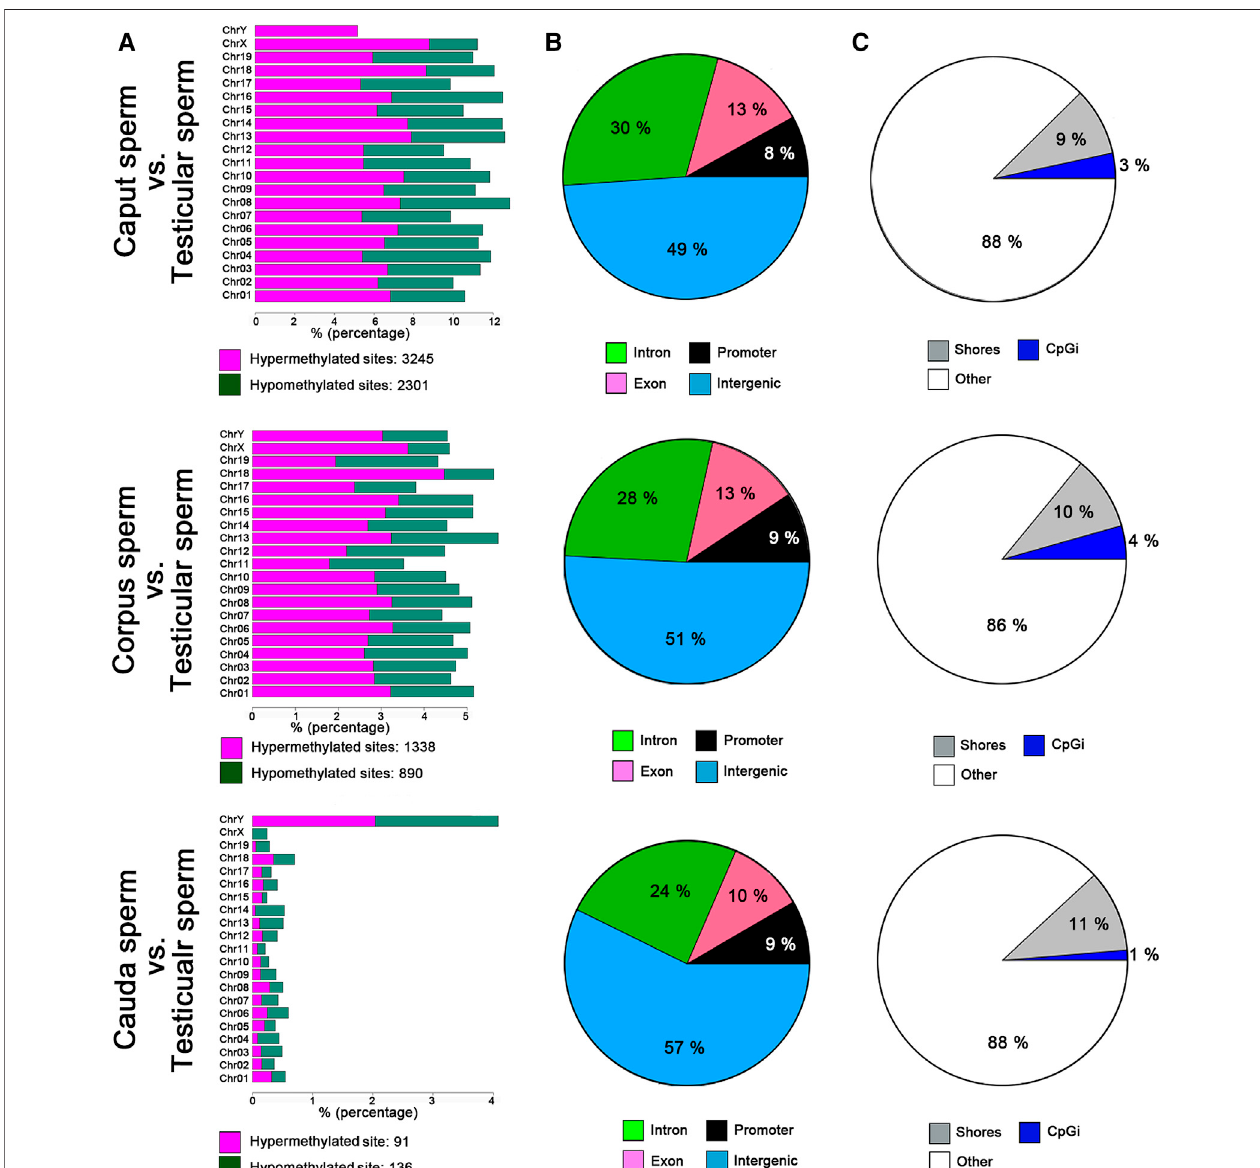
FIGURE 3 | Global changes in sperm DNA methylation pro fi les at the post testicular level. (A) Distribution of CpG hypermethylated (purple) and hypomethylated sites (green) within each chromosome. (B) Pie charts illustrating the proportions of CpGs covered by RRBS in regions annotated as introns (green), promoter regions (black), exons (purple), or intergenic regions (blue). (C) Pie chart illustrating the proportions of CpGs covered by RRBS in regions annotated as CpG islands (blue), CpG shores (gray) and other regions (white). Results are representative of three independent experiments.